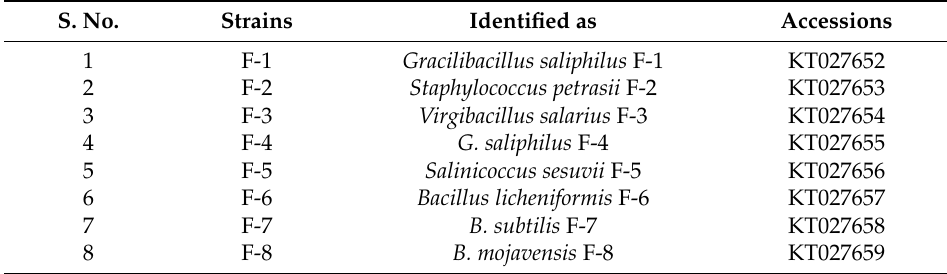
Table 1. 16S rRNA gene sequencing of halotolerant bacterial strains isolated from the rhizosphere of Suaeda fruticose (L.)